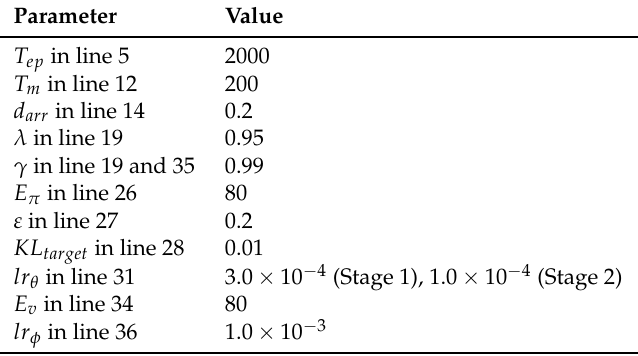
Table 2. Hyper-parameters of our training algorithm described in Algorithm